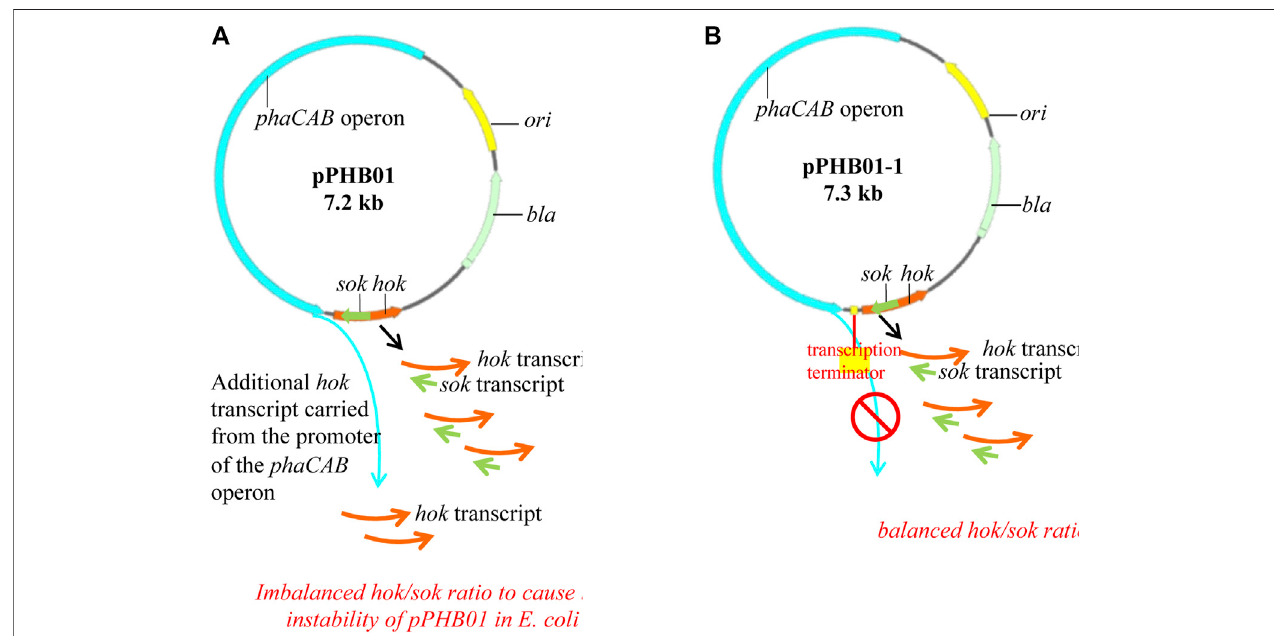
FIGURE 6 | Maps of (A) pPHB01 and (B) pPHB01-1, where pPHB01-1 was constructed by inserting a 57-bp E. coli ρ factor-independent terminator (thrLABC, ECK120033737) into the pPHB01 to isolate the phaCAB operon and the hok/sok system.